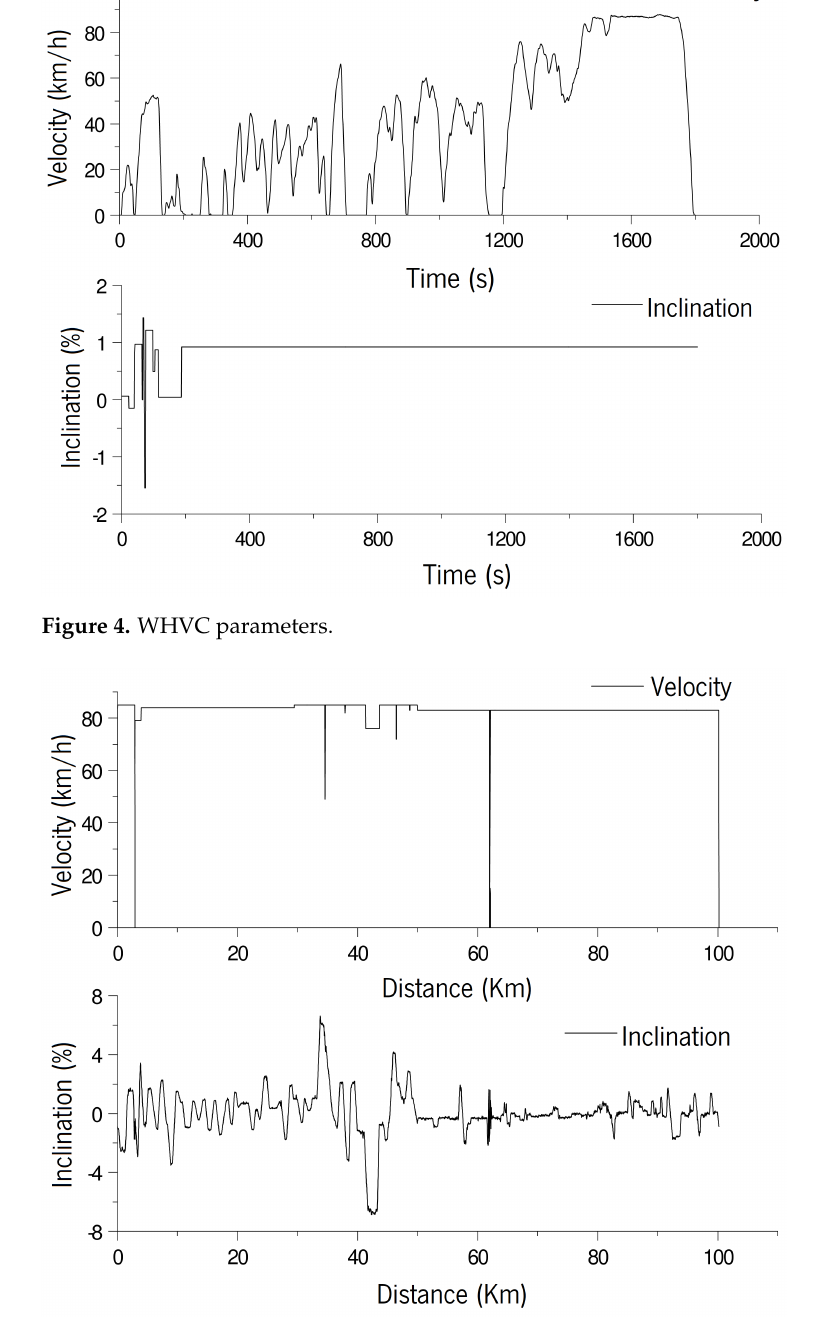
Figure 5. Long Haul cycle run parameters from AVL